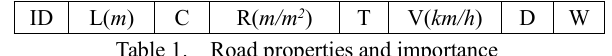
Table 1. Road properties and importance Where ID is the index of road, L is length, C is connectivity, R is network density, T is traffic flow, V is average velocity, D is degree of intensity, W is the importance of the road.